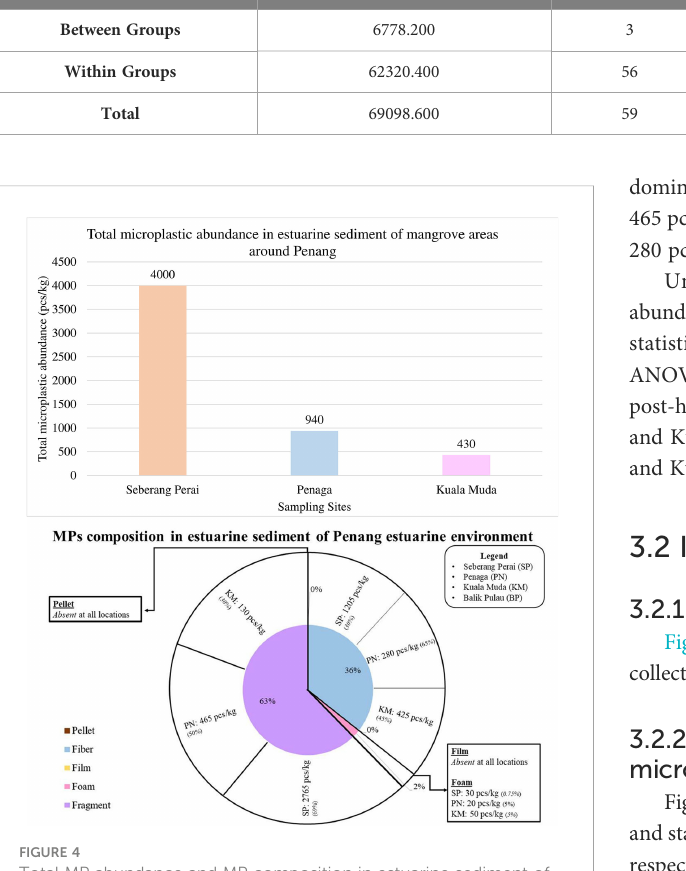
FIGURE 4 Total MP abundance and MP composition in estuarine sediment of each site in Penang.